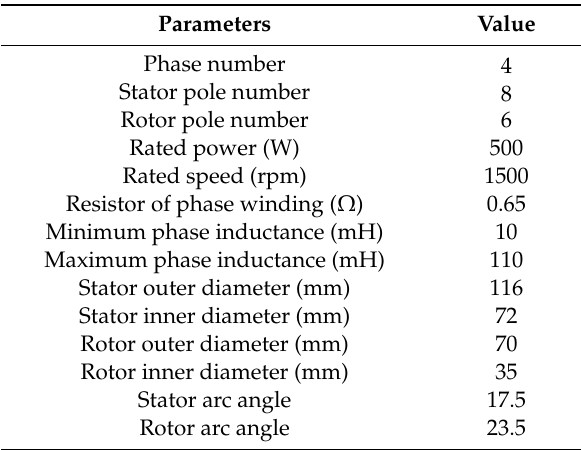
Table 1. Parameters of SRM.